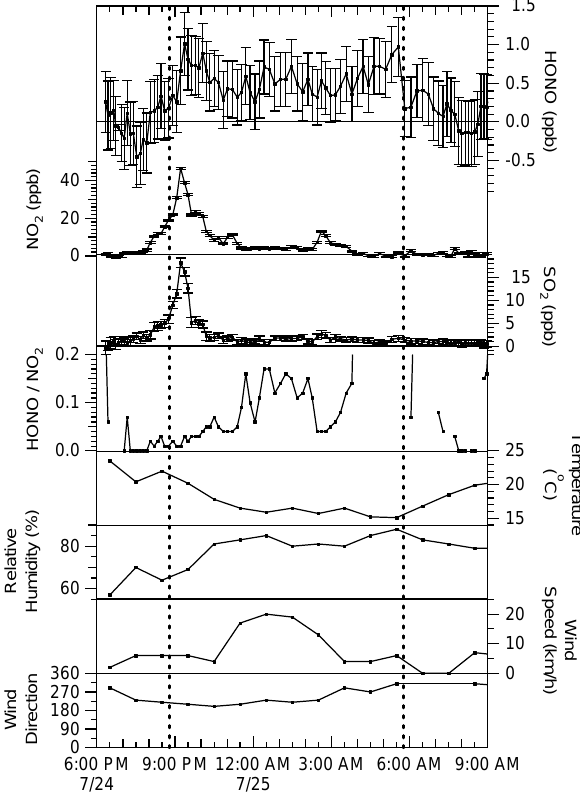
Fig. 3. Nocturnal measurements 24/25 July at East Point, Saturna Island. Vertical dashed lines represent times of sunset and